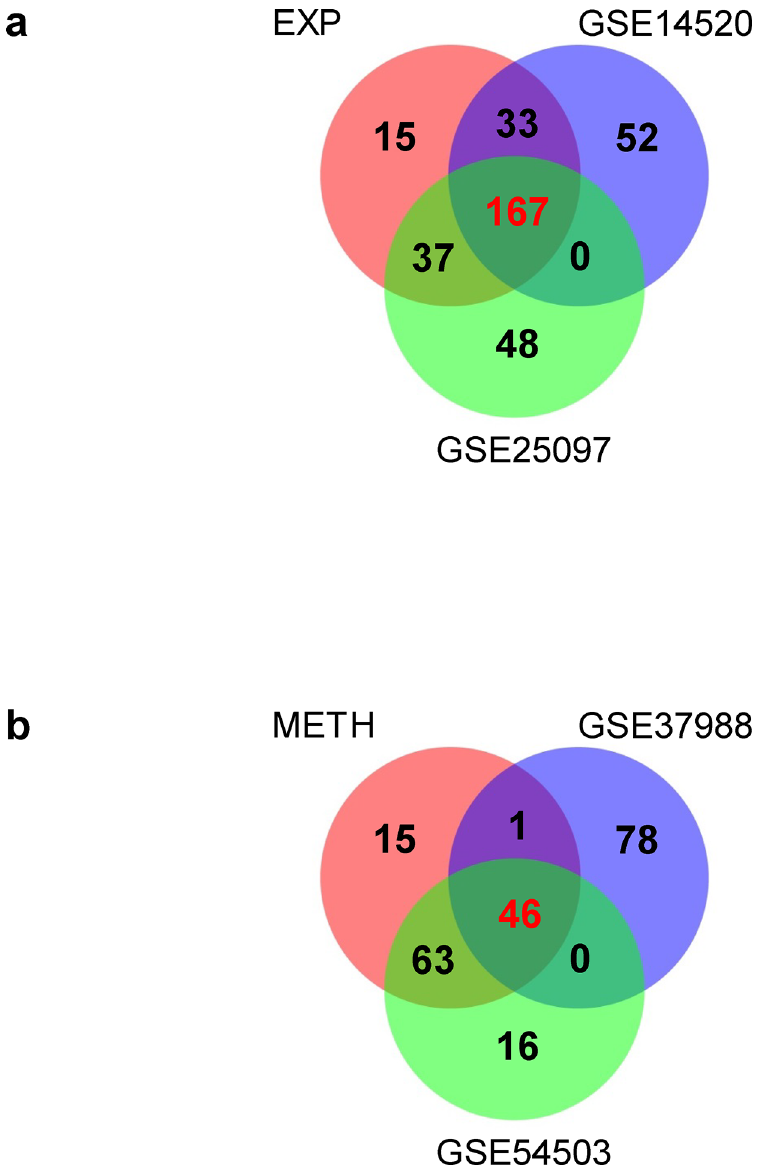
Fig 3. Venn diagram of the overlapping inflammation-related genes having significant mRNA expression (a), or DNA methylation (b) in HBV-related HCCs in our study with public datasets. EXP, genes with aberrant expression; METH, genes with aberrant